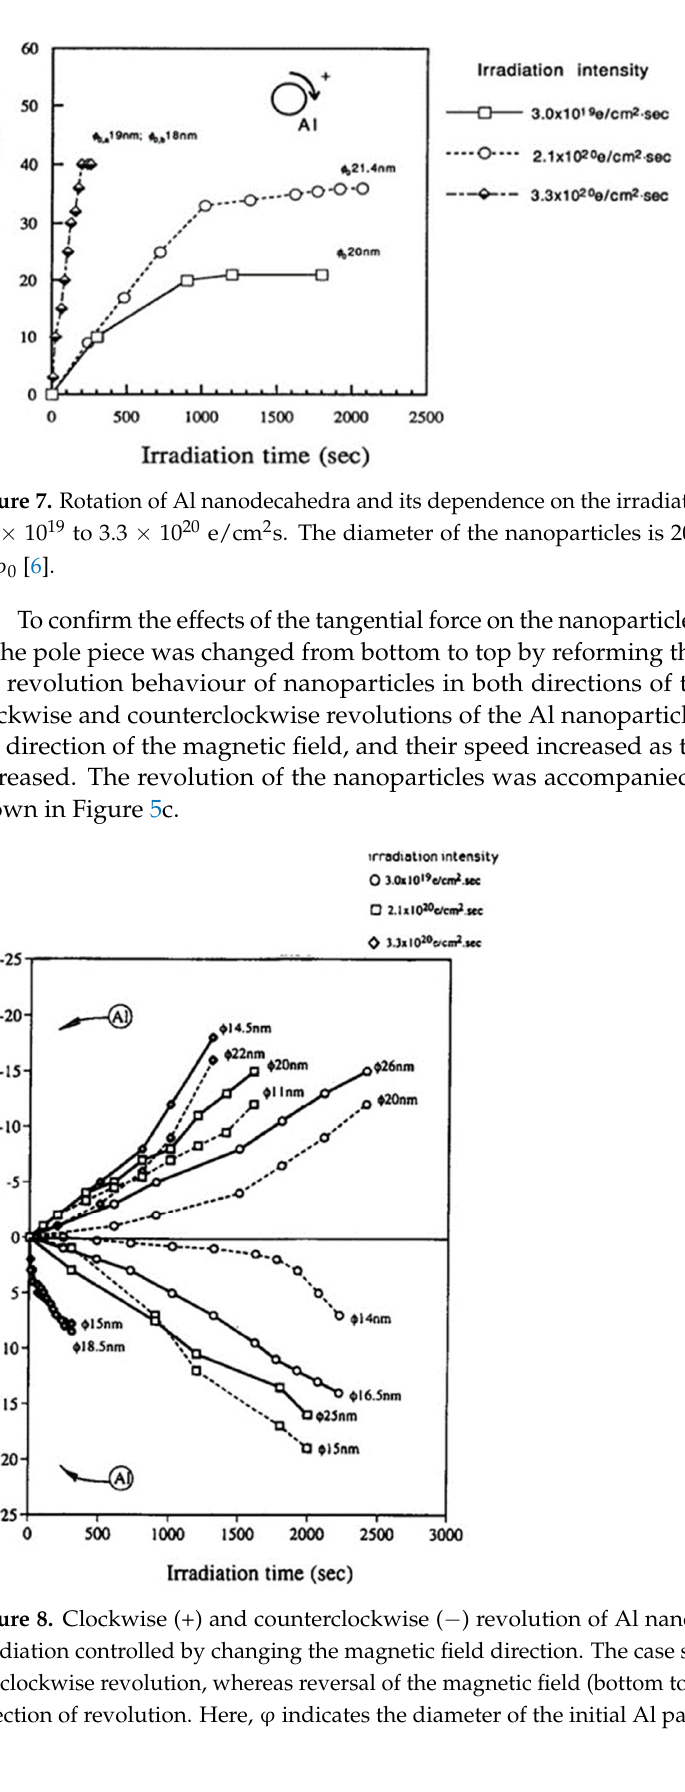
Figure 8. Clockwise (+) and counterclockwise (−) revolution of Al nanoparticles during electron irradiation controlled by changing the magnetic field direction. The case shown in Figure 5 induced the clockwise revolution, whereas reversal of the magnetic field (bottom to top) induced the opposite direction of revolution. Here, ϕ indicates the diameter of the initial Al particle